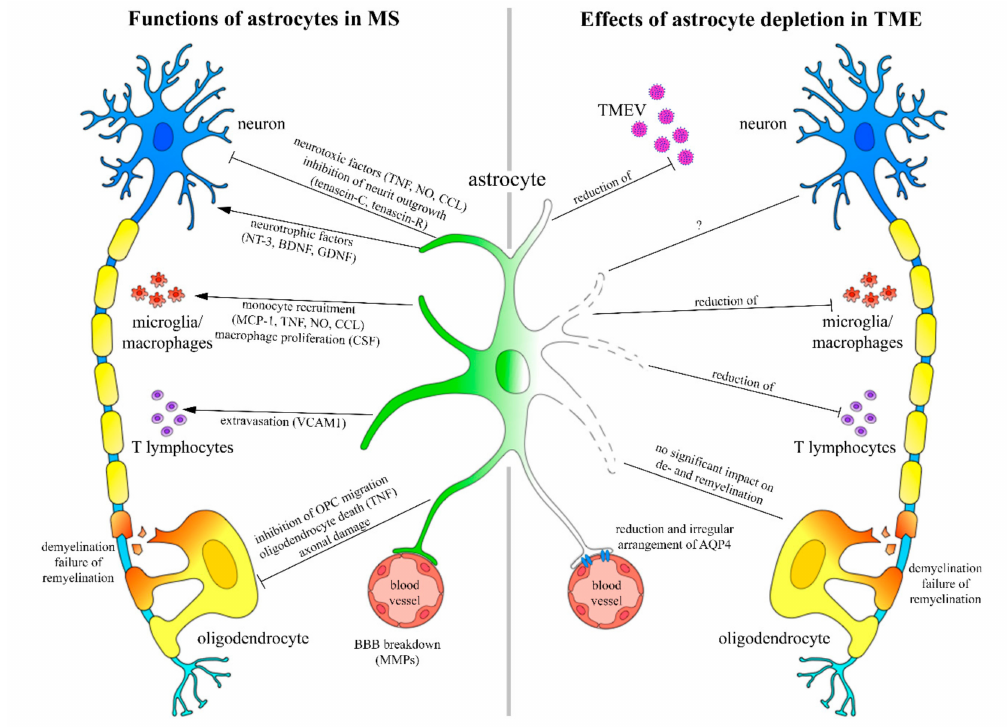
Figure 10. Presumed roles of astrocytes in multiple sclerosis (MS) and Theiler’s murine encephalomyelitis. Functions of astrocytes in MS are shown on the left side of the scheme [8,48–51]. They include an interaction with neurons by secreting neurotrophic as well as neurotoxic factors. Microglia / macrophage recruitment and T lymphocyte extravasation are induced by astrocytes as well. Furthermore, astrocytes are able to inhibit oligodendrocyte precursor cell (OPC) migration and induce oligodendrocyte death. Secretion of matrix metalloproteinases (MMPs) like MMP-9 significantly contributes to an impairment of the blood brain barrier (BBB). The right side of the schematic drawing summarizes the e ff ects of astrocyte depletion in Theiler’s murine encephalomyelitis (TME). Astrocyte depletion during the early and late phase of TME resulted in a lower number of TMEV positive cells and a reduction of spinal cord inflammation with no e ff ect on de- and remyelination. Furthermore, astrocyte depletion was associated with a reduction and an irregular arrangement of aquaporin 4 (AQP4) water channels, as well as a shortening and disorganization of intermediate filaments in perivascular astrocytes. BDNF, Brain-derived neurotrophic factor; CCL, chemokine ligand; GDNF, Glial cell line-derived neurotrophic factor; NO, nitric oxide; NT-3, Neurotrophin-3; TNF, tumor necrosis